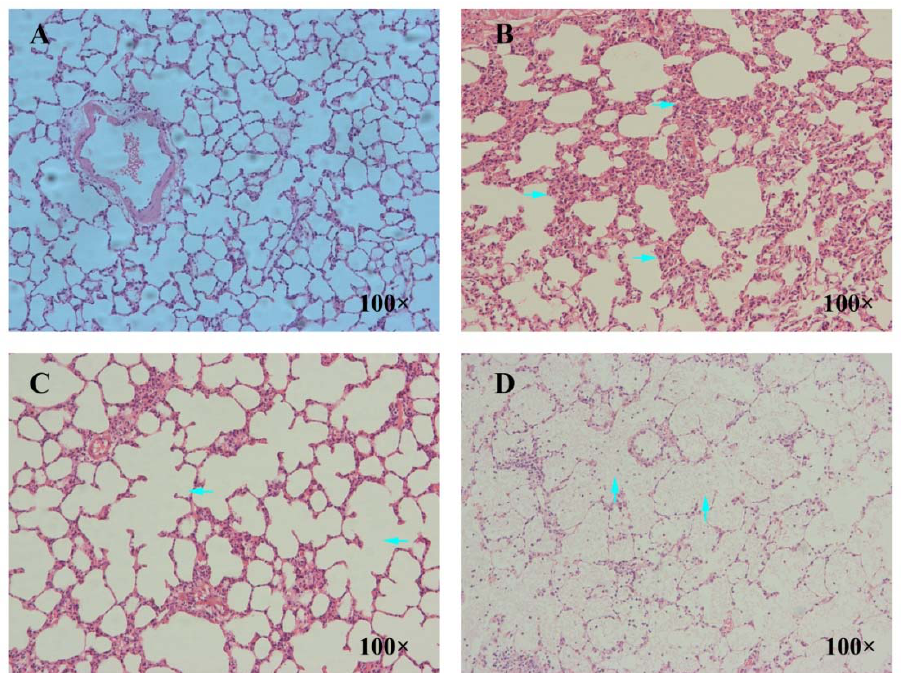
Figure 9. Effect of La 2 O 3 NPs on pathological morphology of lung tissue in rats. These images were taken at 100 × magnification for the control group ( A ), low-dose group ( B ), medium-dose group, ( C ) and high-dose group ( D ). By contrast, the alveolar septum in the control group was thickened ( right arrows in ( B )), and alveolar fusion occurred in the medium-dose group ( left arrows in ( C )). The alveolar cavity in the high-dose group was filled with collagen fibers, fibroblasts, and lymphocytes ( up arrows in ( D )).